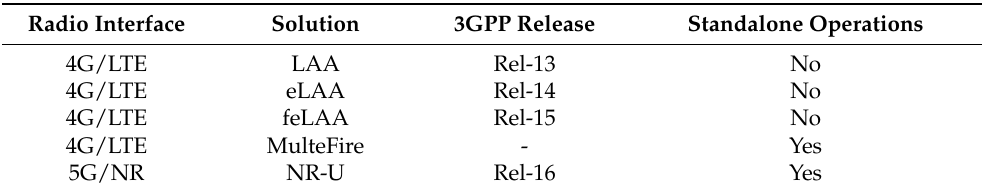
Table 2. List of 3GPP products and functional solutions enabling data transmission in unli- censed